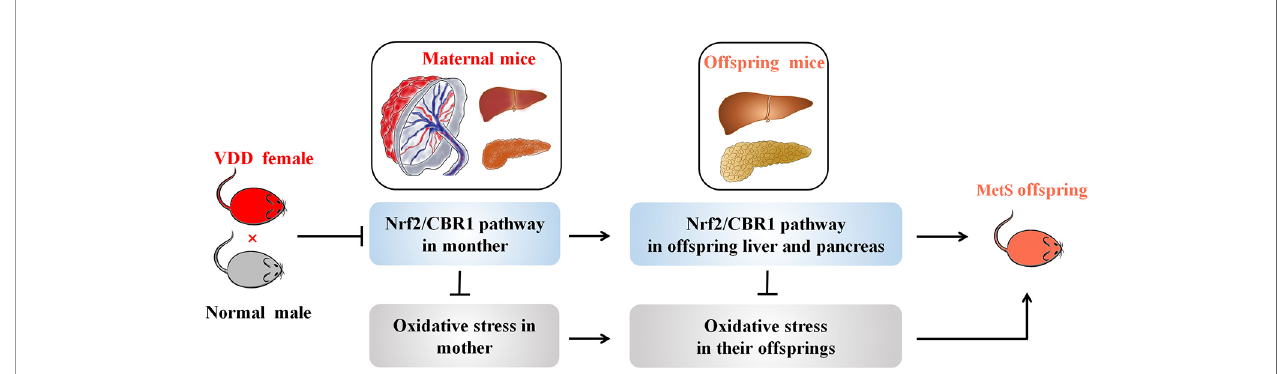
FIGURE 7 | A working model illustrating the effect of maternal VDD on MetS in their offspring. A working model depicting how maternal VDD effects offspring metabolic function was shown. Maternal VDD leads to the inhibition of Nrf2/CBR1 pathway both in mother and their offspring. Further, the depression of the Nrf2/ CBR1 pathway in both the mother and her offspring is the main cause of oxidative stress leading